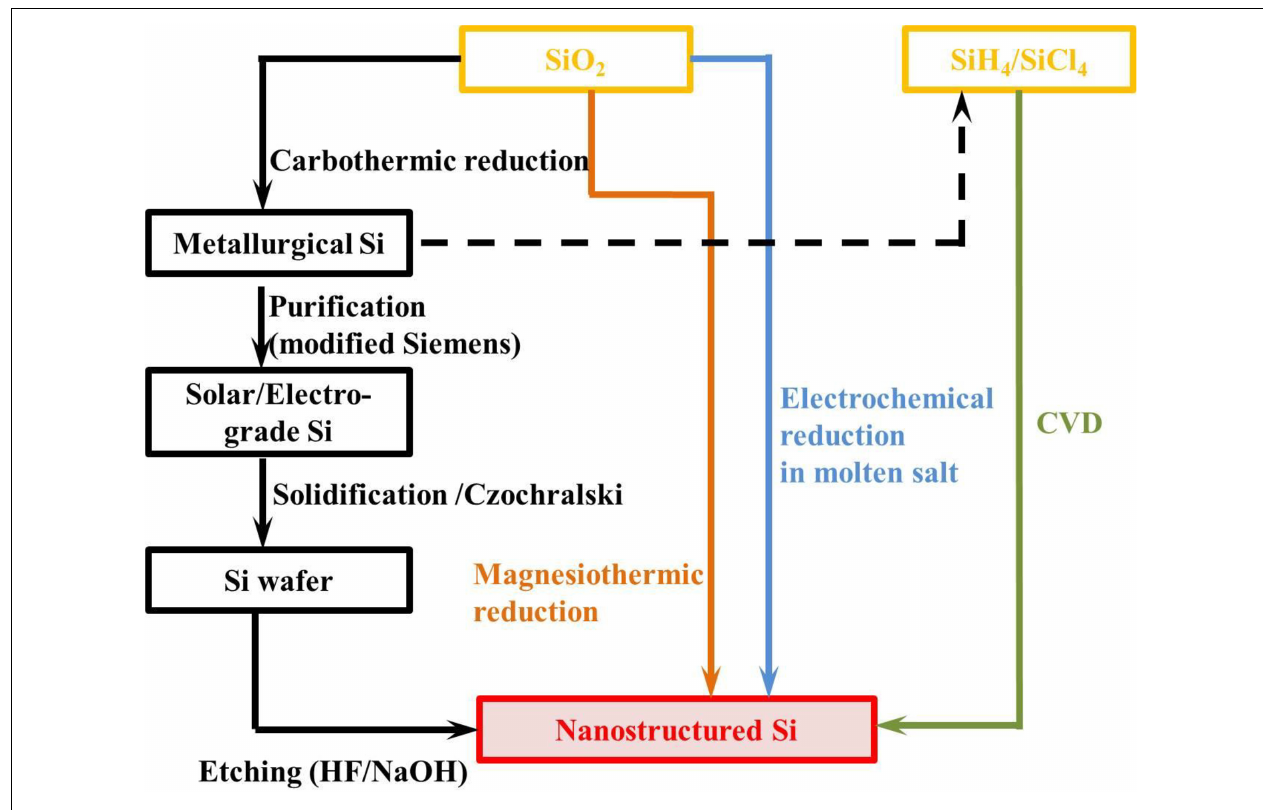
FIGURE 1 | Schematic diagram of the preparation of nanostructured silicon via different routes.